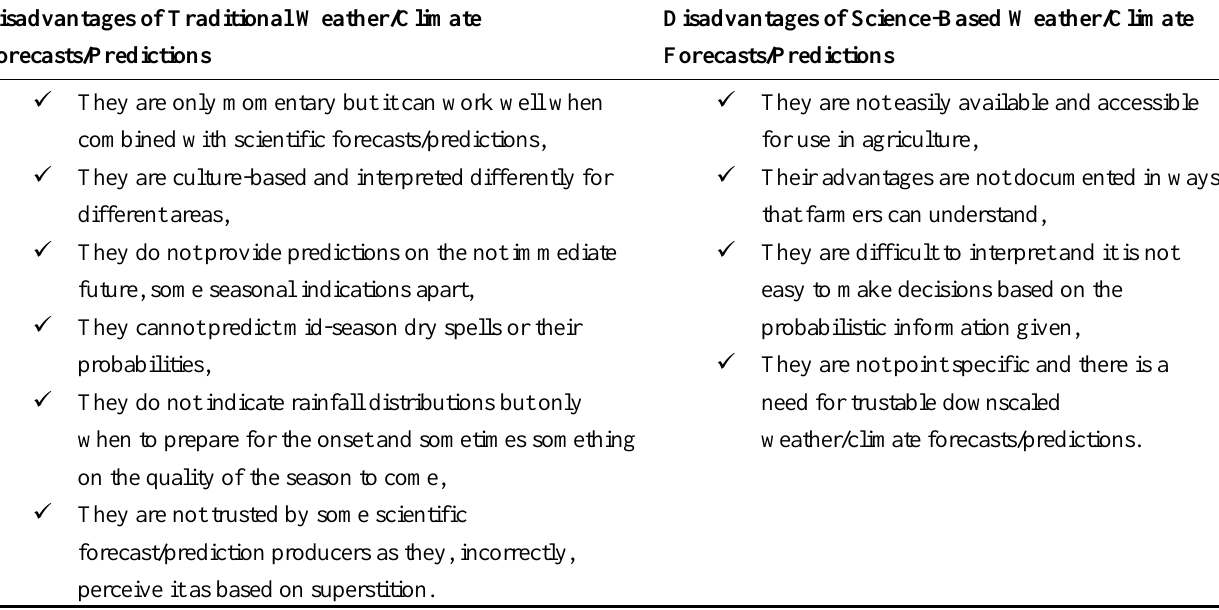
Table 3. Disadvantages of using traditional weather/climate forecasts/predictions and disadvantages of using science-based weather/climate forecasts/predictions as derived from interviews with farmers in 2008 and 2012